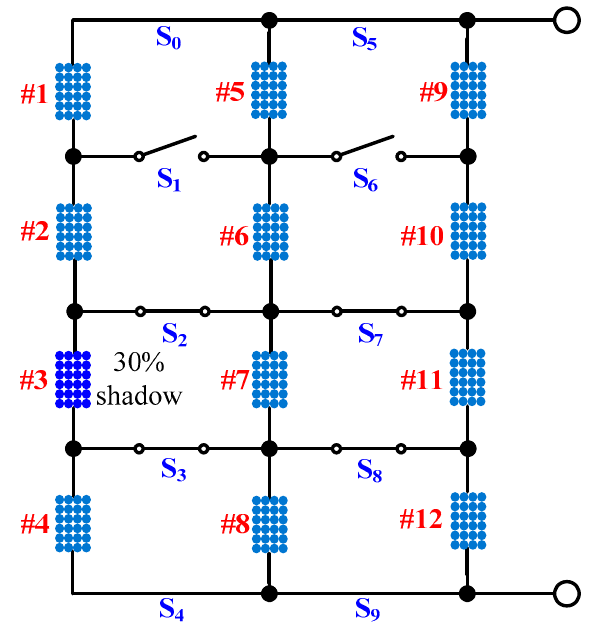
Figure 10. An optimized version of Figure 8.